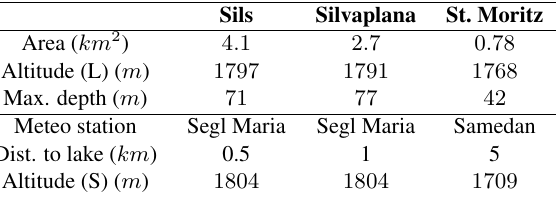
Table 1: Characteristics of the target lakes. Altitude (L) and altitude (S) denote the altitudes of the lake and nearest meteo station respectively. The distance to station is also shown. Sils Silvaplana St. Moritz Area ( km 2 ) 4 . 1 2 . 7 0 . 78 Altitude (L) ( m ) 1797 1791 1768 Max. depth ( m ) 71 77 42 Meteo station Segl Maria Segl Maria Samedan Dist. to lake ( km ) 0.5 1 5 Altitude (S) ( m ) 1804 1804